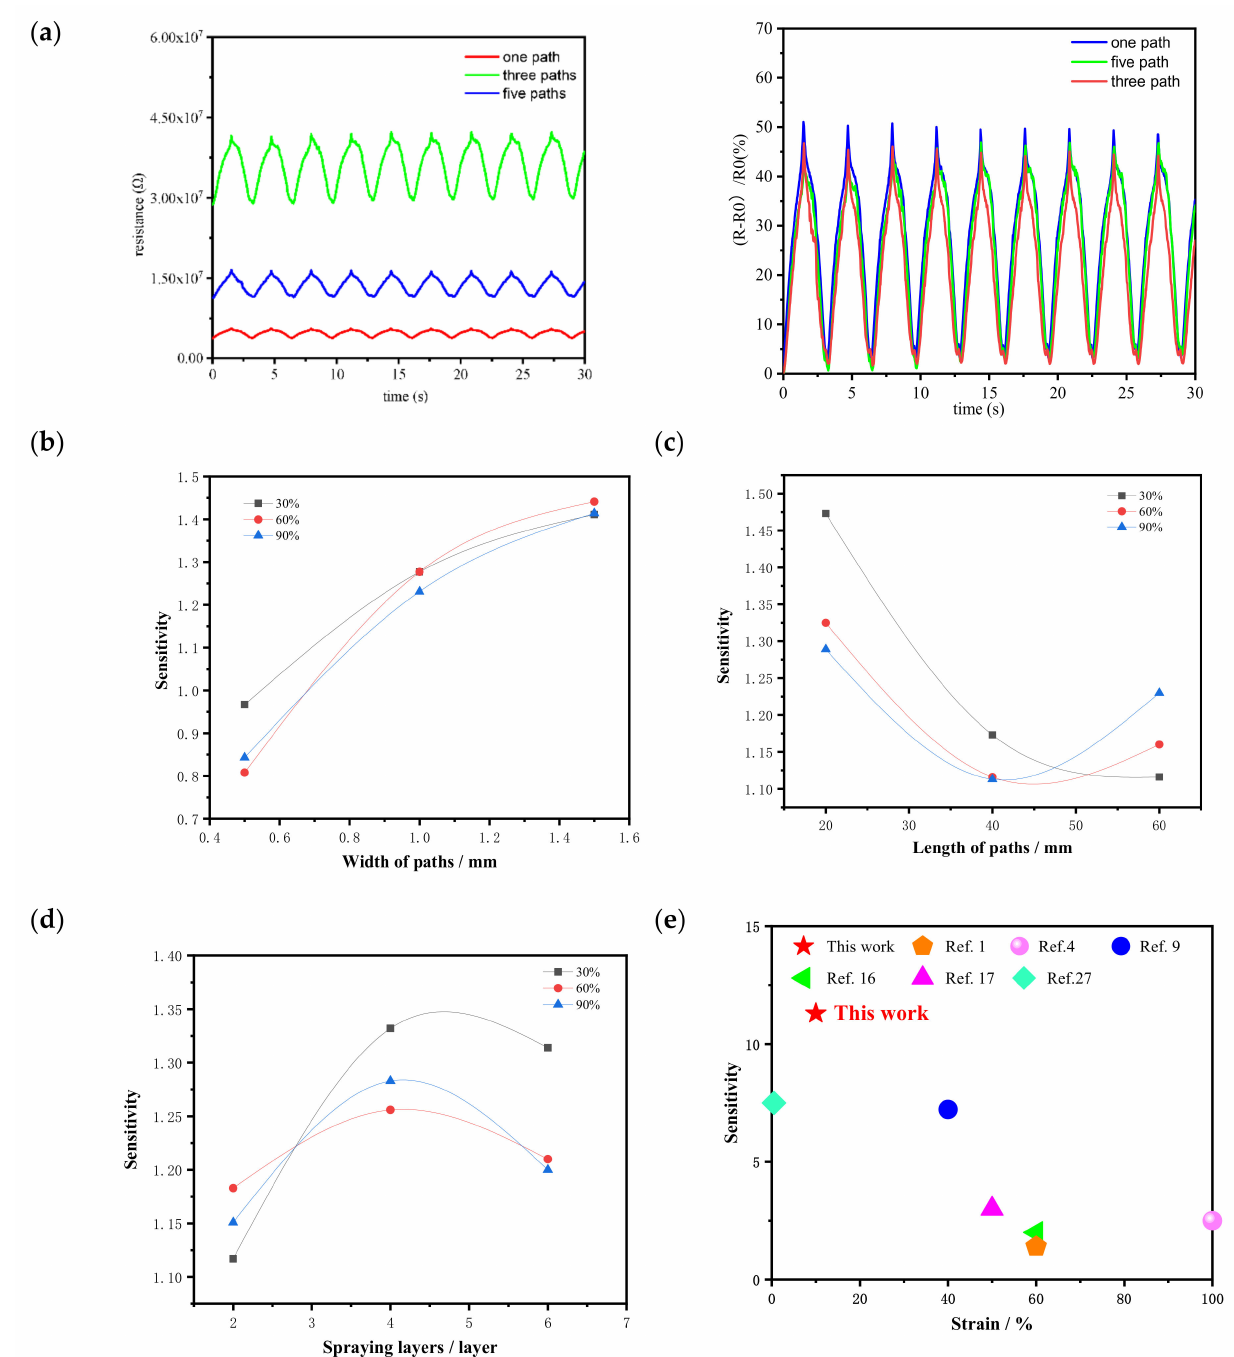
Figure 12. Effect of the pattern parameters on the sensitivity of the flexible sensors: ( a ) resistance and resistance change rate of different number paths; ( b ) widths of paths; ( c ) lengths of paths; ( d ) spraying layers; ( e ) comparison of the GF with sensors fabricated using other